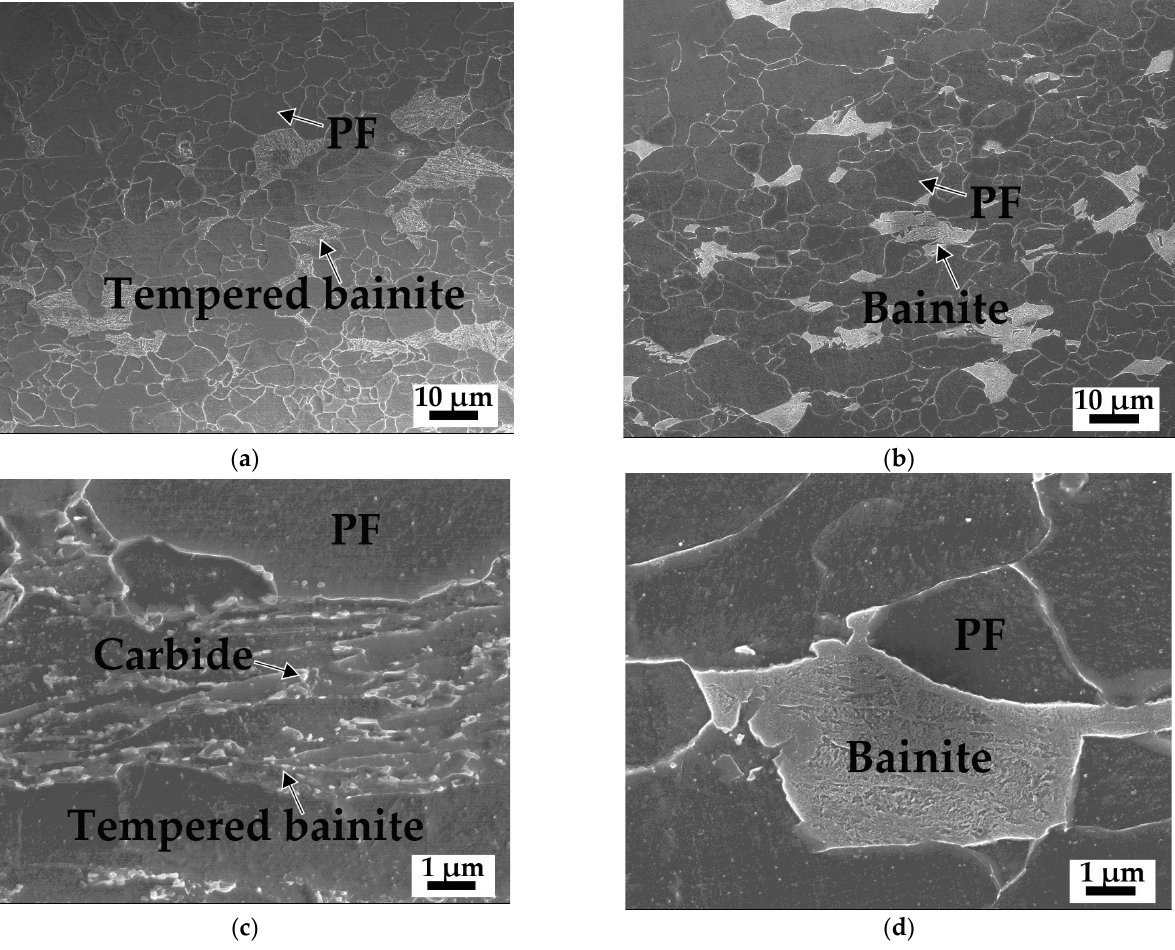
Figure 7. SEM micrographs of ( a , c ) SCHAZ and ( b , d ) BM of location “1” in Figure 1a.